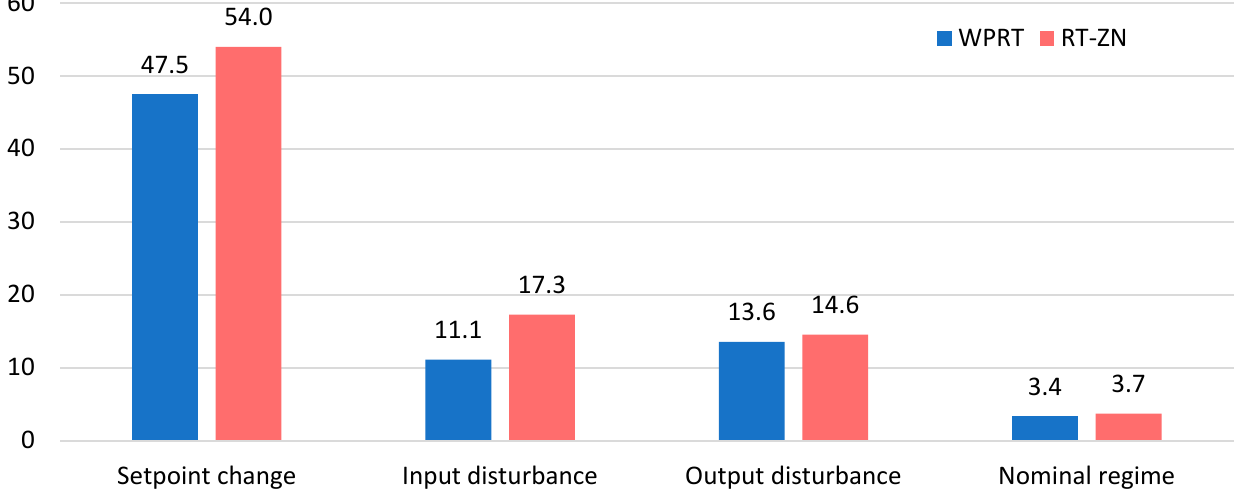
Figure 14. The mean integral absolute error (IAE) values for the performed tests, RT-ZN tuning (red), proposed WPRT method (blue).